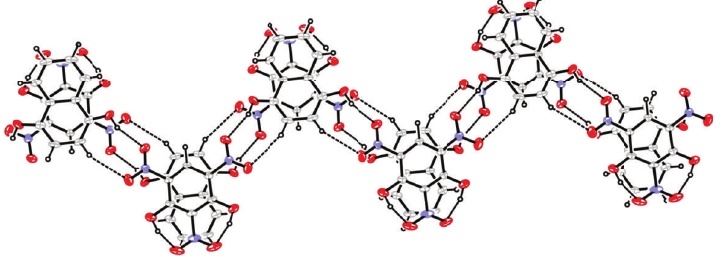
Figure 8: Forming of polymeric chains lying parallel to the [010]